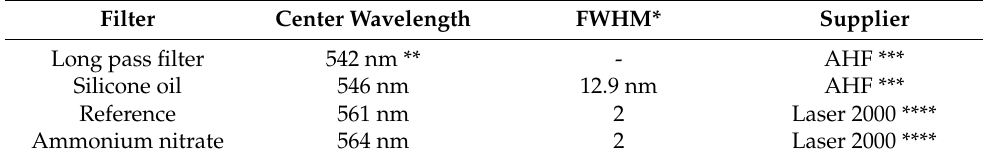
Table A1. Details regarding the optical filters. *** Full width half maximum. ** Edge